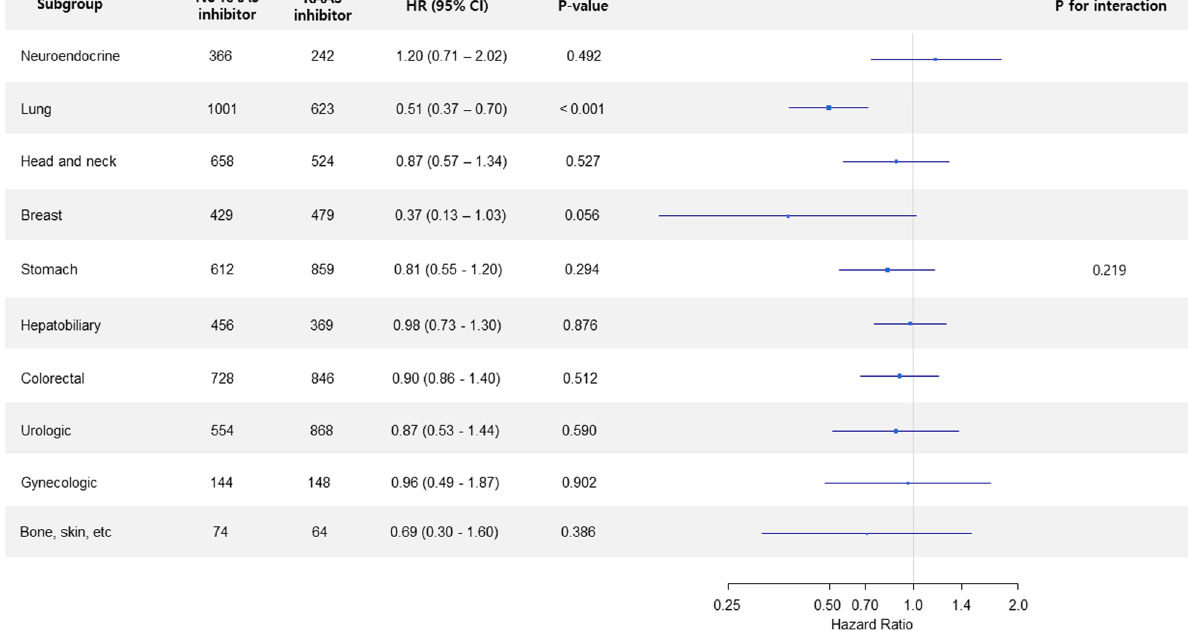
Figure 3. Subgroup analysis for 5-year mortality according to cancer sites. RAAS renin–angiotensin– aldosterone system, HR hazard